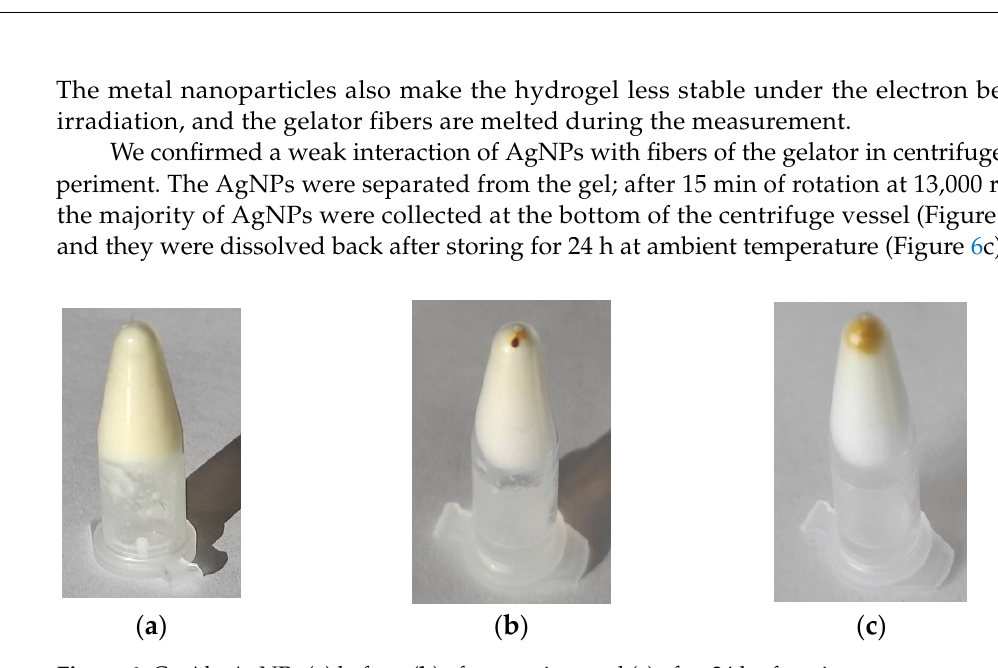
Figure 6. C 12 Ala-AgNPs ( a ) before, ( b ) after rotation, and ( c ) after 24 h of storing.